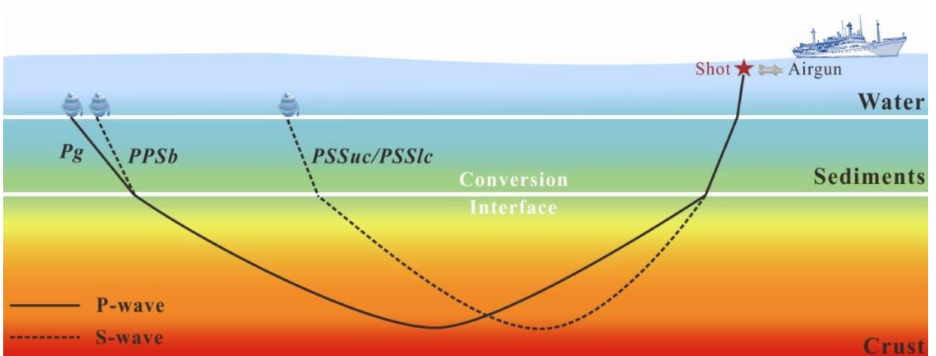
Figure 5. Cartoon illustrating the ray paths of converted S-wave phases. The PPS phases (PPSb) constrain the sediments S-wave velocity, while the PSS phases (PSSuc/PSSlc) constrain the crustal S-wave